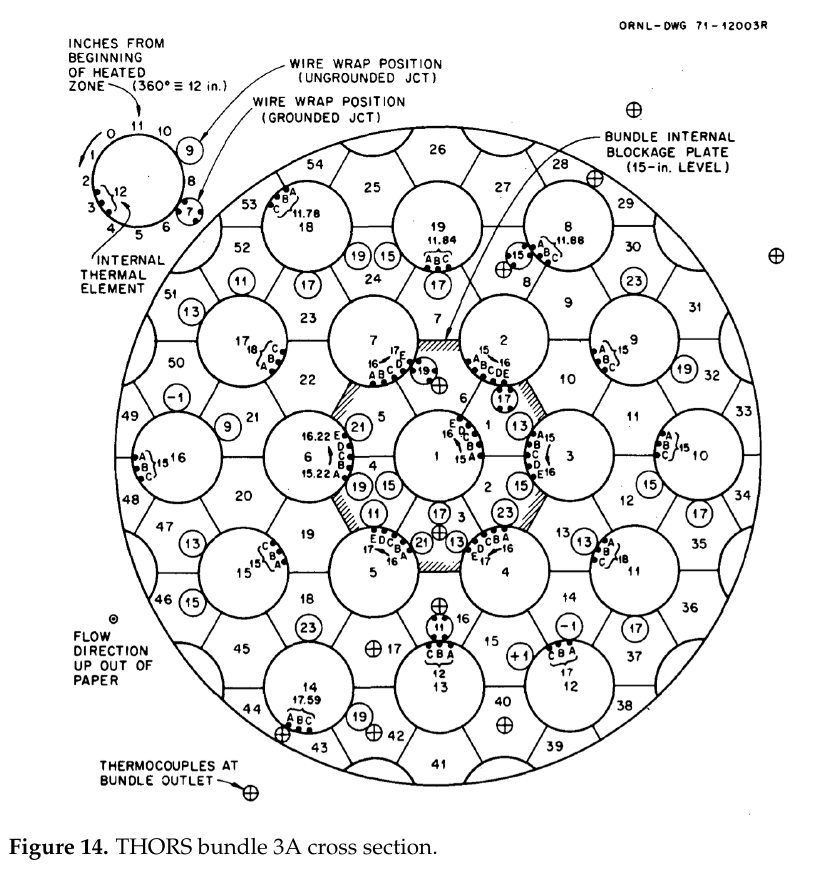
Figure 14. THORS bundle 3A cross section.